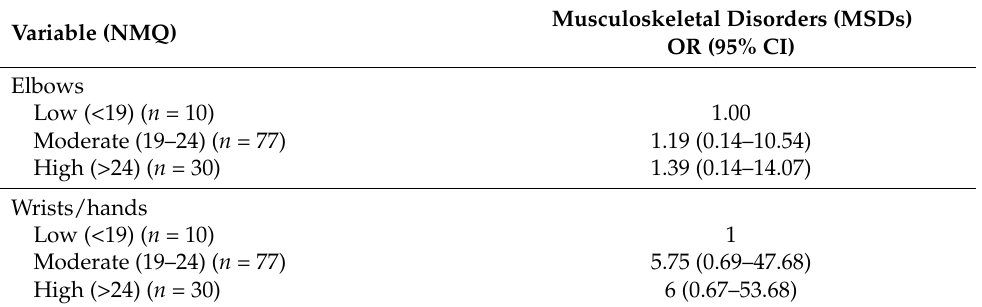
Table 3. Hazard ratio analysis between the Nordic musculoskeletal questionnaire (NMQ) and scale I of the checklist for MSDs.